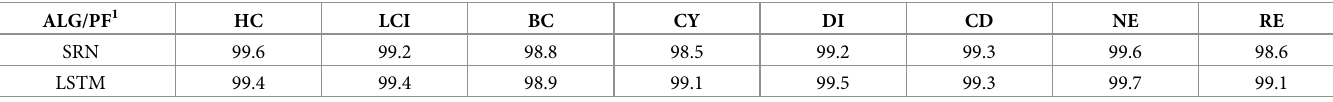
Table 3. ACC lab of all pathological findings for Att-RethinkNet based on LSTM and SRN for kidney data set. ALG/PF